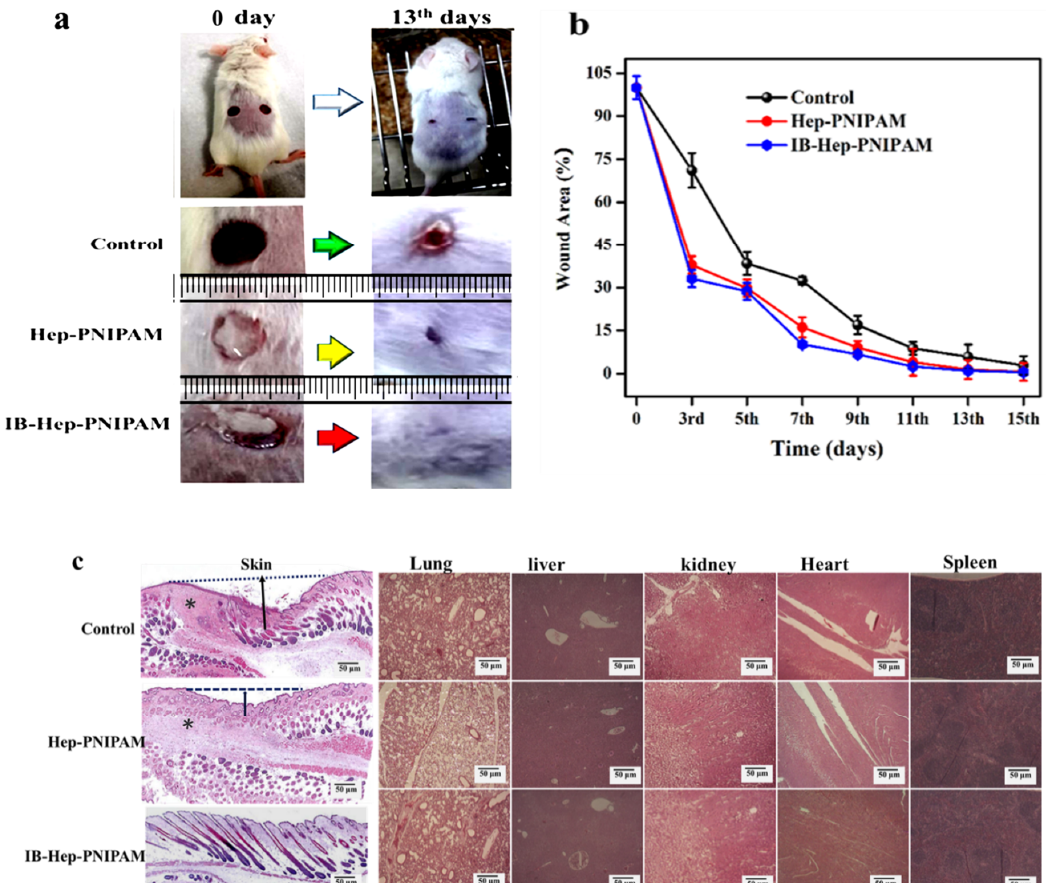
Figure 7. Wounds treated with Hep-PNIPAM, IB-Hep-PNIPAM, and PBS (control group). ( a ) Hydrogel administration and wound recovery from days 1–15, ( b ) Relative wound healing rates in mice treated with Hep-PNIPAM, IB-Hep-PNIPAM, and PBS. Data are represented as means ± SD. ( c ) Histological observations of wounded skin and organ sections stained with H&E and examined on day 15. Bars = 50 μm. * = granulation in the dermis.